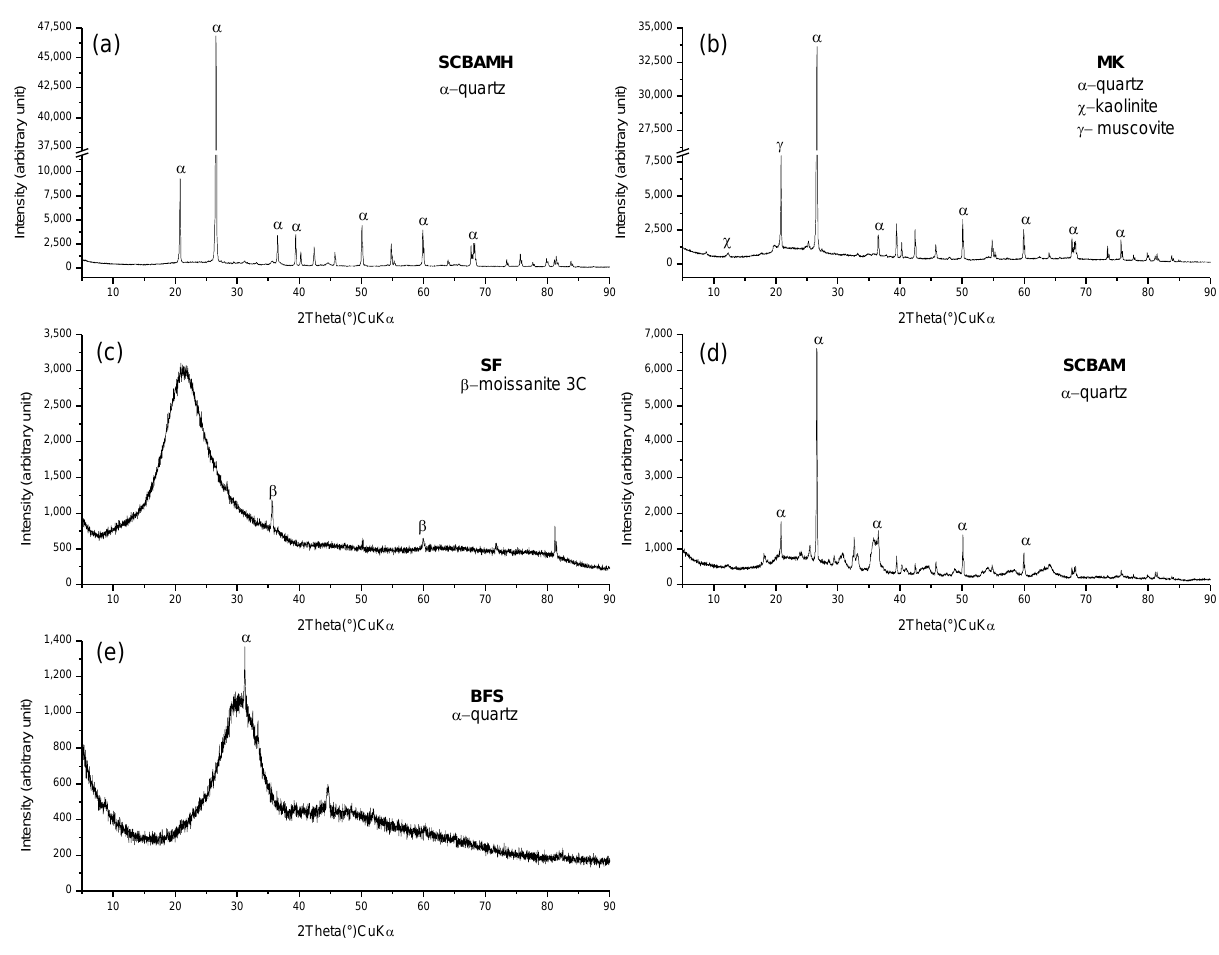
Figure 1. XDR spectrum of ( a ) SCBAMH, ( b ) MK, ( c ) SF, ( d ) SCBAM, and ( e ) BFS. The BFS micrograph (Figure 2a) shows that the slag particles are granular and with sharp edges. BFS also exhibits a diversity of particle size and shape; the smaller particles cover the surface of the larger ones. In addition, the material has a compact appearance